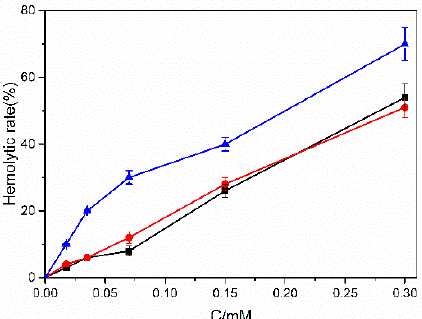
Figure 3. The hemolytic rate of human red blood cells (RBC) under different concentrations of hair dyes FB( ● ), BR2( ■ ) and VBB( ▲ ). ( n = 3).